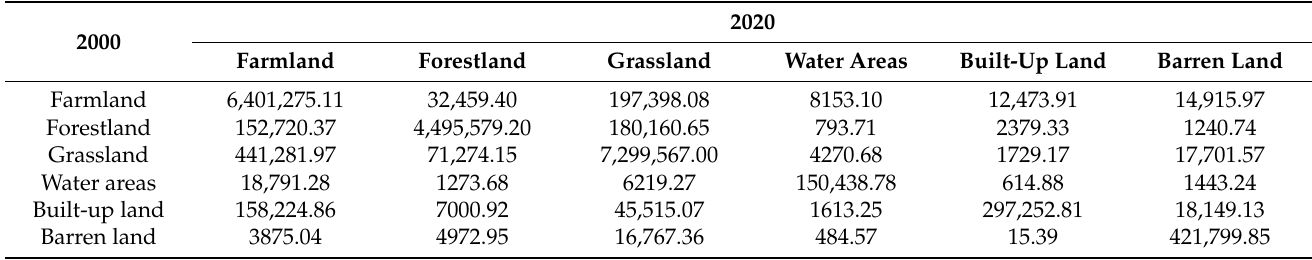
Table 4. Land-use transfer matrix of Shaanxi Province from 2000 to 2020.